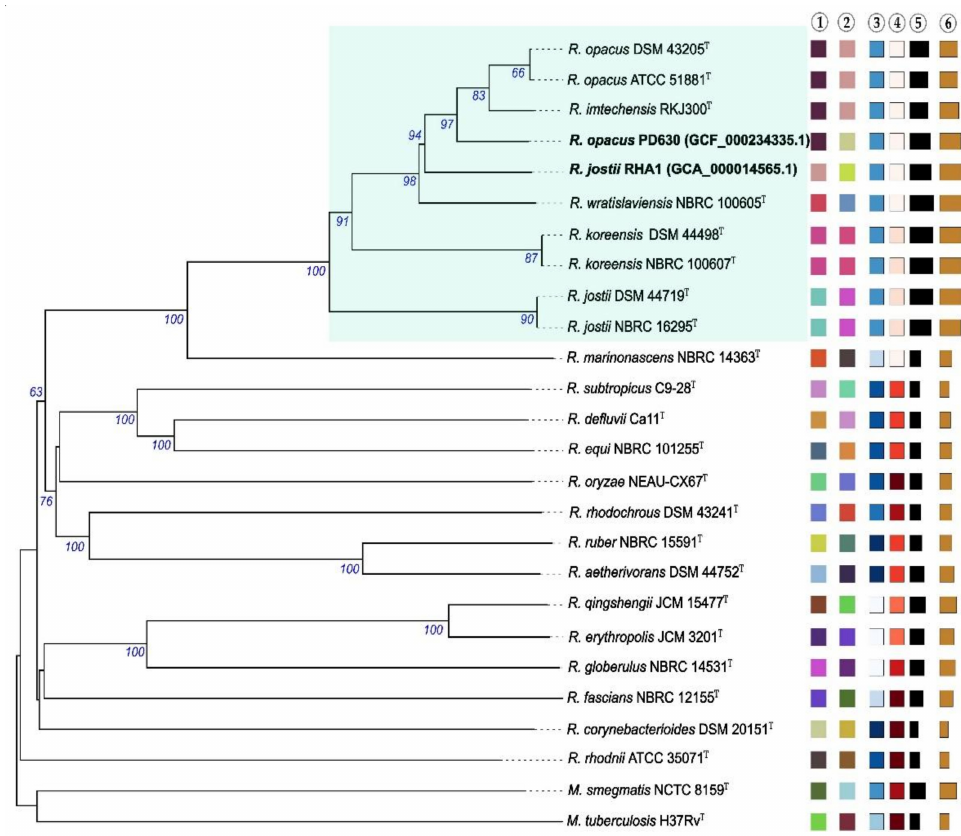
Figure 1. Phylogenomic tree inferred using the Type Strain Genome Server (https://tygs.dsmz.de/ accessed on 13 February 2021) by Genome BLAST Distance Phylogeny approach (GBDP), using distances calculated from genome sequences. The branch lengths are scaled in terms of GBDP distance formula d5 . The numbers below branches are GBDP pseudo-bootstrap support values >60% from 100 replications, with an average branch support of 79.8%. The tree was rooted at the midpoint. The light blue box highlights Rhodococcus species (including oleaginous strains RHA1 and PD630) belonging to the group C, according to the classification proposed by Sangal et al. [10]. Leaf labels are annotated by affiliation to 1 (cid:13) species and 2 (cid:13) subspecies clusters, predicted by the digital DNA:DNA hybridization (dDDH) calculator service; 3 (cid:13) genomic G+C content (Min.